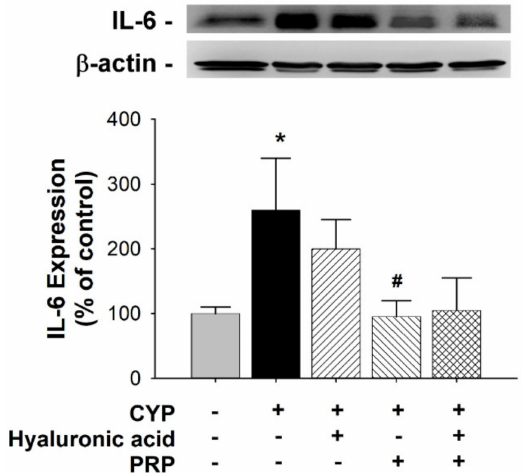
Figure 7. Alteration of IL-6 expression in bladder as indicated by Western blot analyses between saline-injected control, CYP plus intravesical instillation with normal saline, CYP plus intravesical instillation with hyaluronic acid (1 mg / mL), CYP plus intravesical instillation with PRP, and CYP plus intravesical instillation with hyaluronic acid (1 mg / mL) plus PRP groups. Each bar denotes the mean ± SD of six individual rats. * p < 0.05 contrasted to the control group. # p < 0.05 compared to the CYP